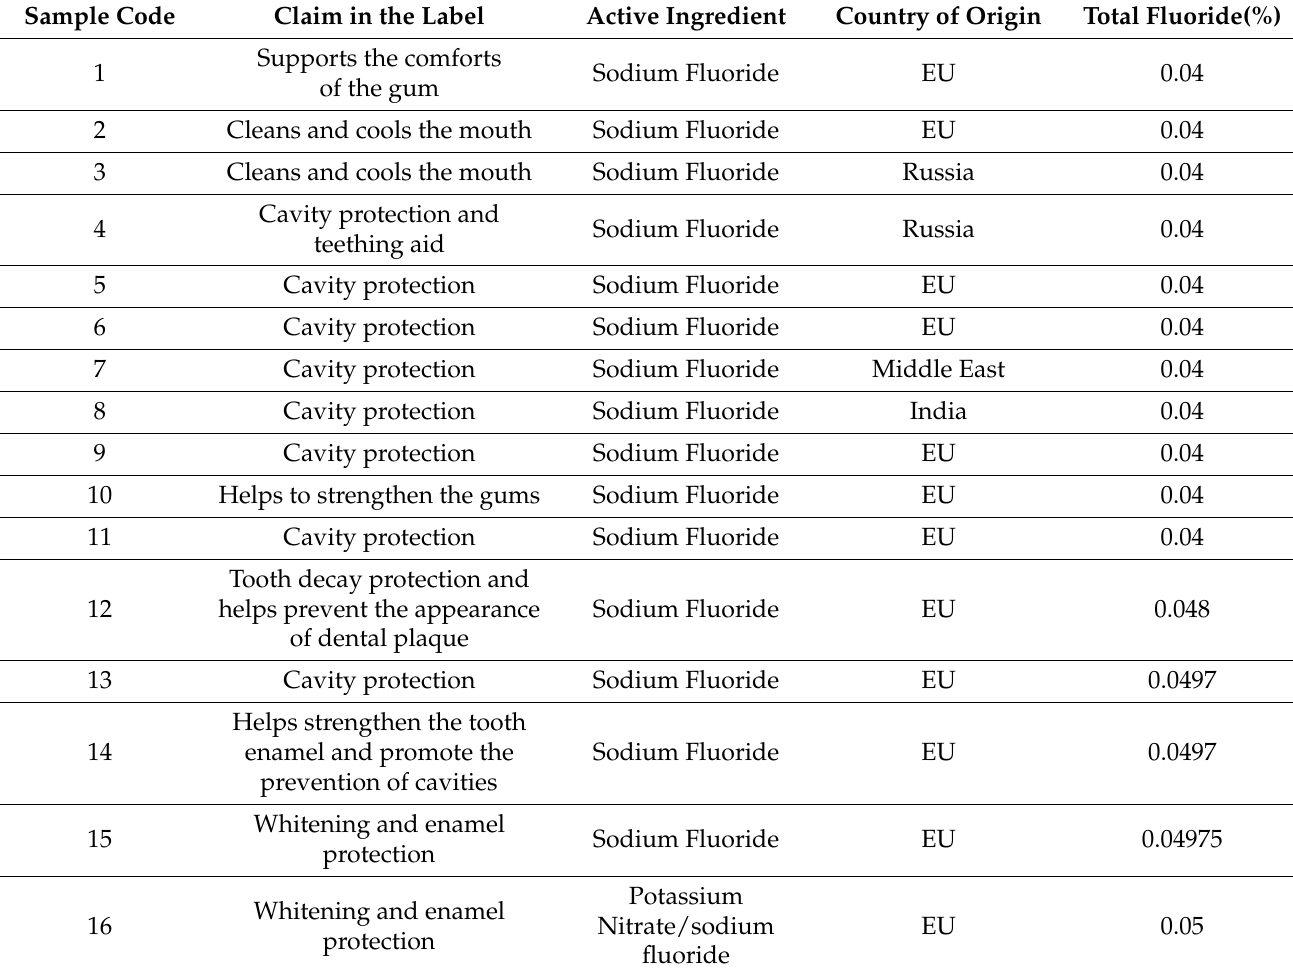
Table 3. List of Tested Toothpaste Products According to Total Fluoride Content and Sample Characteristics. Sample